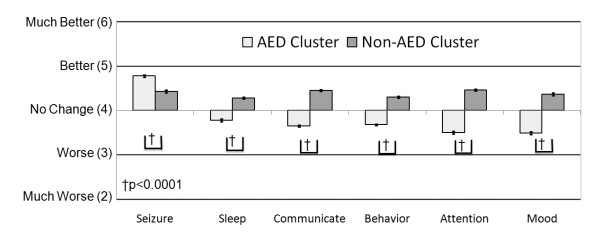
Treatments for clinical seizures cluster into anti-epileptic drug and non-anti-epileptic drug treatments. In general, anti-epileptic drug treatments were perceived as improving seizures significantly more than non-anti-epileptic drug treatments but significantly worsening other clinical factors.